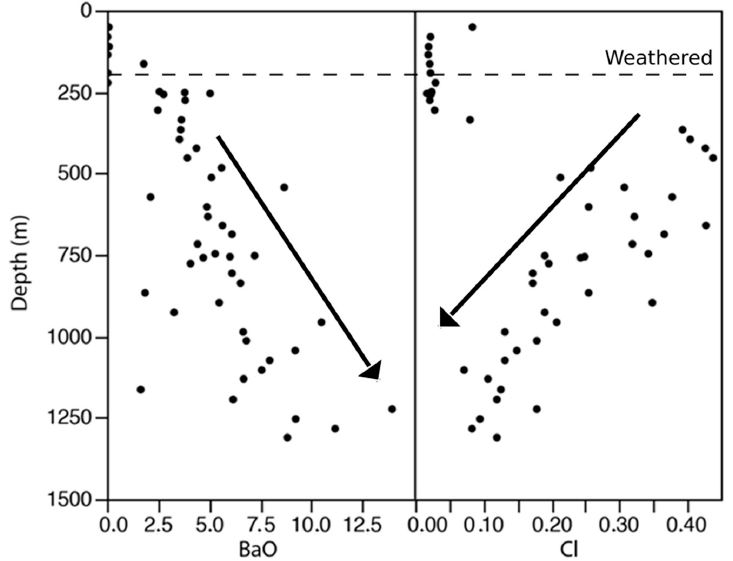
Figure 8. BaO and Cl (in wt %) as a function of depth within the Saint-Honoré Fe-carbonatite. Note that the uppermost 250 m are strongly weathered.